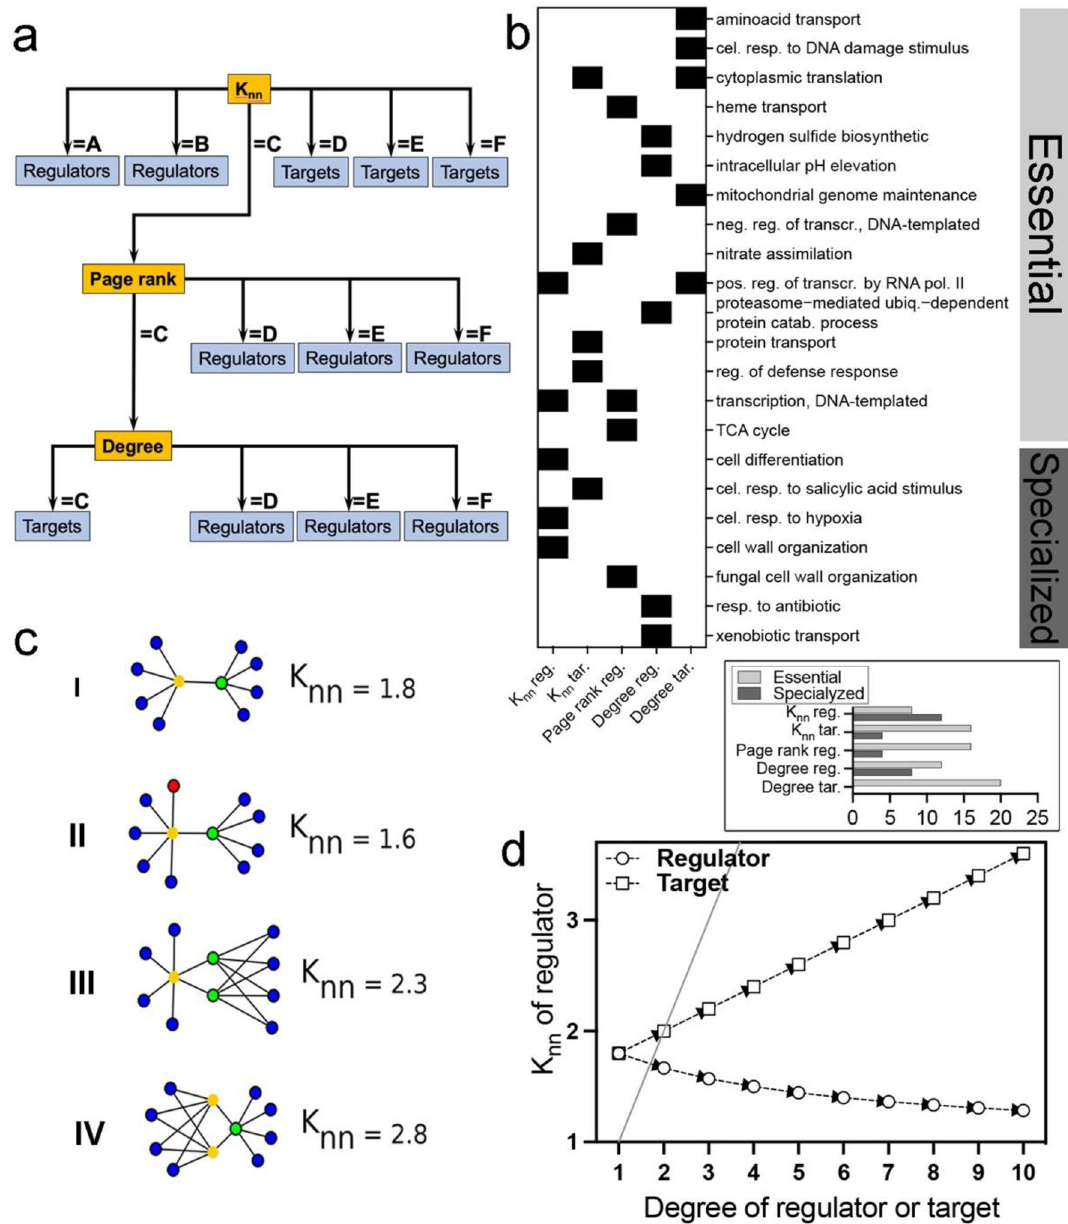
Figure 2. Decision tree, GO, and network simulation analysis. ( a ) The consensus tree which “A”, “B”, “C”, “D”, “E”, and “F” are the bins from the discretization step. Orange squares are the node’s features, and blue squares are the classified leaves; ( b ) the biological process (rows) of genes in tree’s leaves in ( a ) and the feature that leads to the leaves (K nn , degree, or page rank) (columns). The “reg.” means regulators, “tar.” means targets. The black box indicates the presence of a given GO term in genes at that tree leaves. The histogram in the box below the heatmap depicts the percentage of GO terms from genes that lie in each leaf type; ( c ) representation of hypothetical networks. The K nn was calculated for the regulators (yellow nodes). Blue nodes are genes with just one connection. The red node depicts a blue node duplication. The green nodes represent other regulators or genes regulated by many regulators. “I”, “II”, “III”, and “IV” represents networks in an initial state, after a gene duplication or during pervasive transcription, after duplication of a different regulator, and after duplication of the regulator in which K nn is calculated, respectively; ( d ) simulation of K nn evolution of regulators from ( c ). The X-axis is the degree of targets and regulators, and the Y-axis is the regulator’s K nn . The diagonal grey line is the identity line (a line where every point has proximal X and Y coordinates), which by crossing only the second point, indicates divergencies since the beginning of the